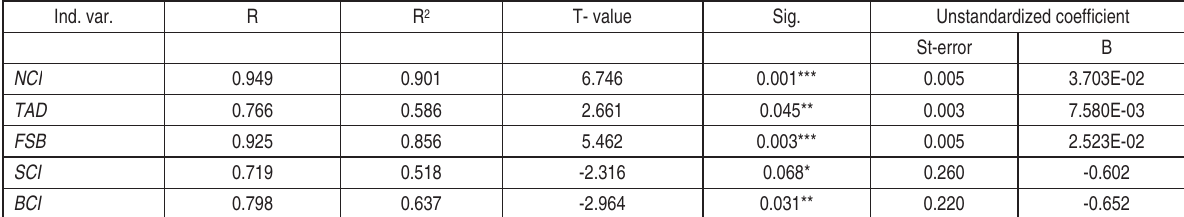
Table 4. Regression analysis of structural indicators for the european union banking system on EMU convergence criterion bond yields (Maastricht criterion) Ind.